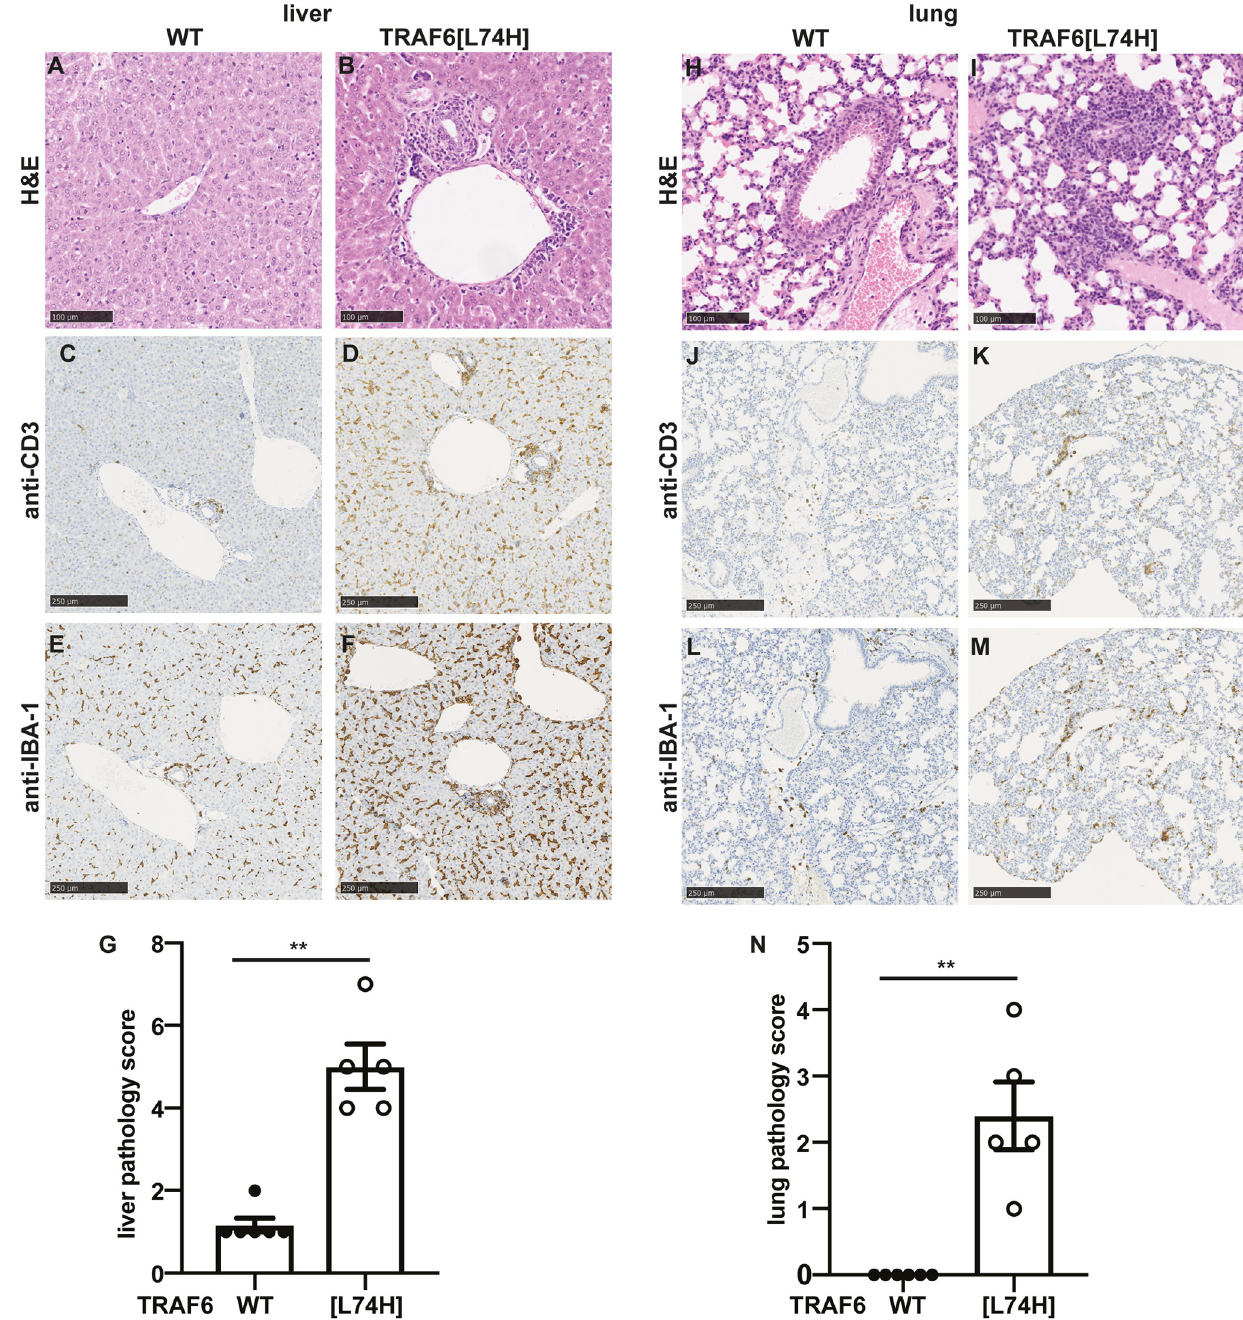
Fig 5. Liver and lung inflammation seen in TRAF6[L74H] mice. (A-F) Representative image showing haematoxylin and eosin (H & E)-stained liver sections from WT (A) and TRAF6[L74H] (B) mice. BV, blood vessel (C, D) As in A, B except that skin sections were processed for immunohistochemistry staining using anti-CD3 antibody. (E, F) As in C, D except that anti-IBA-1 antibody was used. (G) Bar graphs showing liver pathology score. (H-M) As in A-F, except that lung sections are shown. (N) As in G, except lung pathology score is shown. Graphs show mean ± SEM. Statistical significance between the two genotypes was calculated using the Mann-Whitney test. �� denotes p < 0.01. Individual values, descriptive statistics and results from the statistical analysis are provided in S5 File.